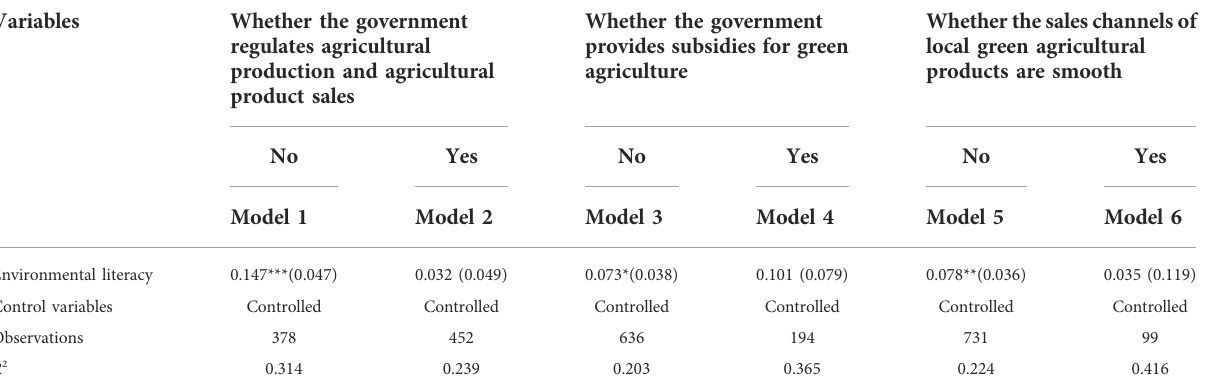
TABLE 13 Heterogeneity in fl uences under different external